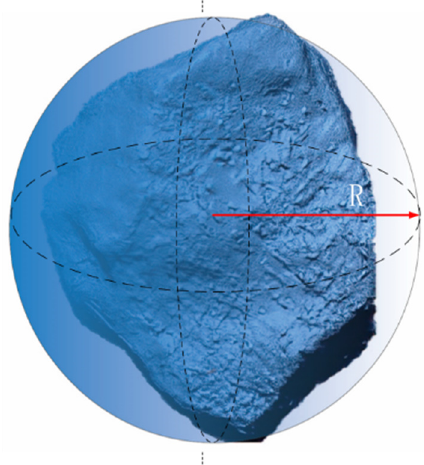
Figure 2. Schematic diagram of minimum external sphericity model.